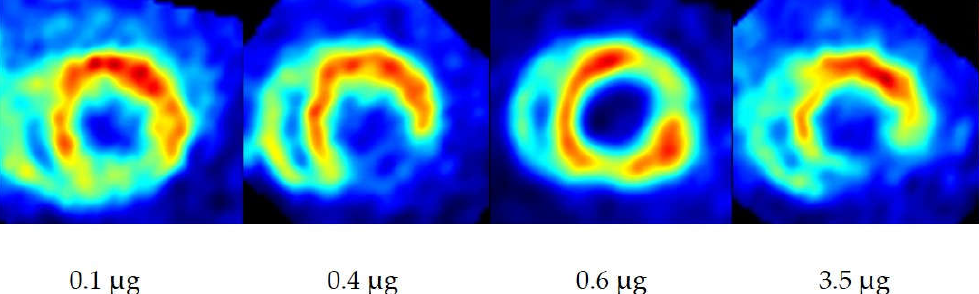
Figure 2. Representative cardiac images in short axis orientation of rat hearts (infarct model) with different applied mass doses of metaraminol and m HED. The sum of metaraminol and m HED is shown beneath the respective image.